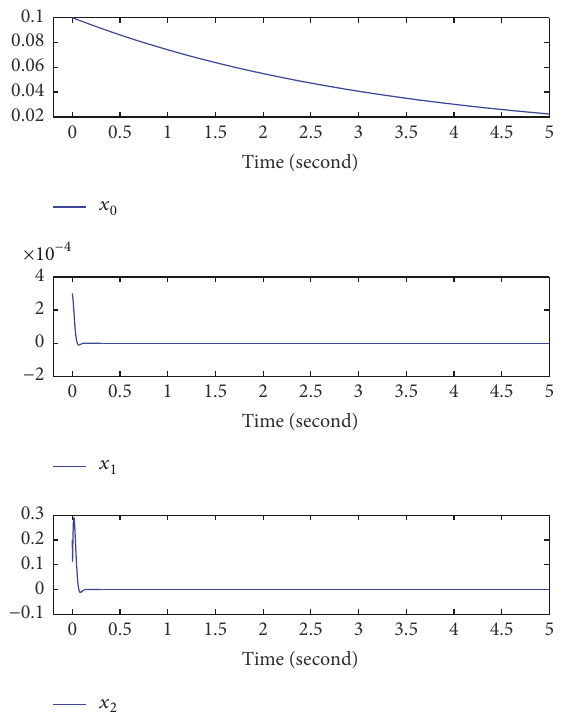
Figure 1: The responses of states 𝑥 0 , 𝑥 1 , and 𝑥 2 .